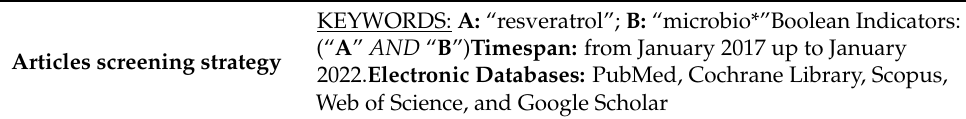
Table 1. Database search indicators. No publication period limitations have been considered.